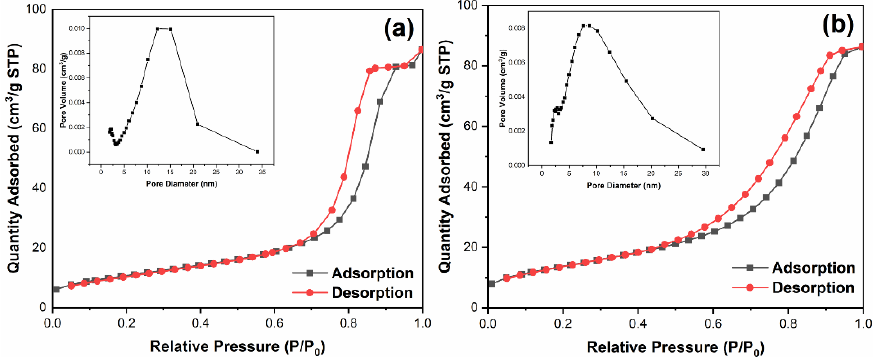
Figure 7. Nitrogen adsorption–desorption isotherms and the corresponding pore size distribution curves of pure TiO 2 ( a ) and Ag@SnO 2 /TiO 2 ( b ).